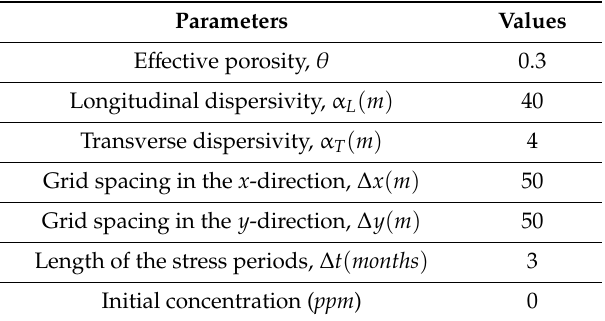
Table 5. Case 2: hydraulic and geometry